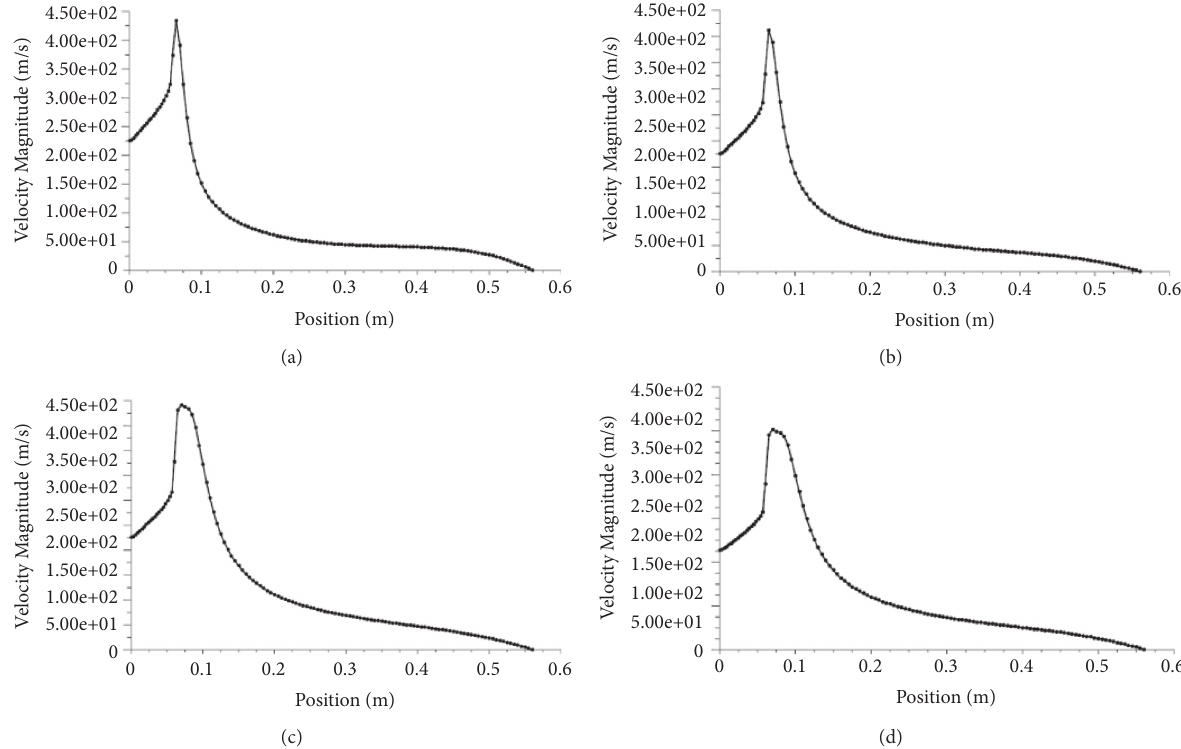
Figure 5: The results of abrasive velocity distribution along the axis with different blasting pressures. (a) The abrasive velocity distribution along the axis with the blasting pressure of 0.5MPa. (b) The abrasive velocity distribution along the axis with the blasting pressure of 0.6MPa. (c) The abrasive velocity distribution along the axis with the blasting pressure of 0.7MPa. (d) The abrasive velocity distribution along the axis with the blasting pressure of